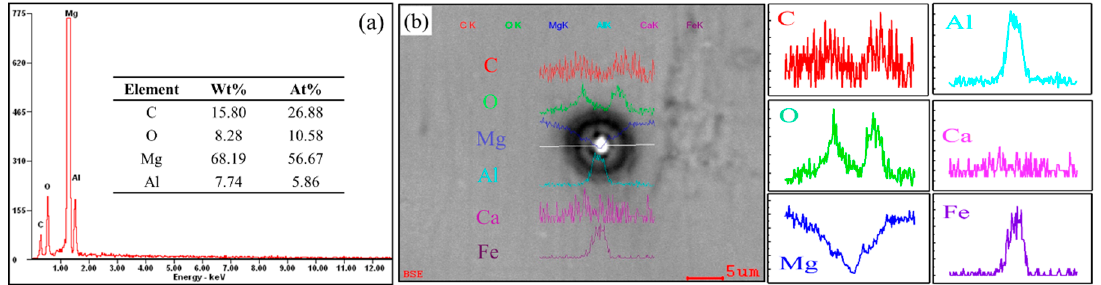
Figure 3. EPMA analyses of two typical particles: ( a ) point analysis of the single particle; ( b ) line analysis of the duplex-phase particle.